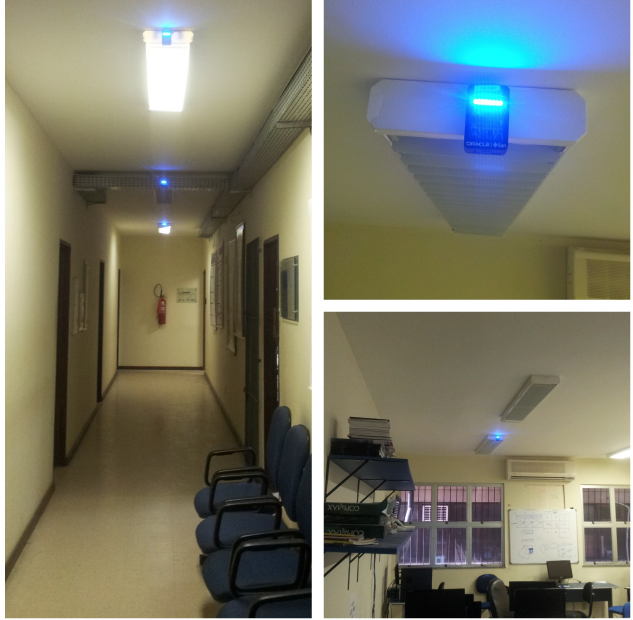
Figure 3. Testbed scenario on Computer Engineering